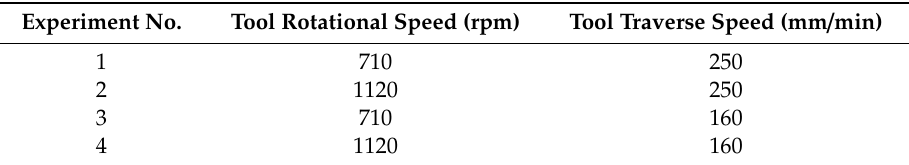
Figure 1. Experimental setup used for performing friction stir welding. Table 4. Experimental plan.